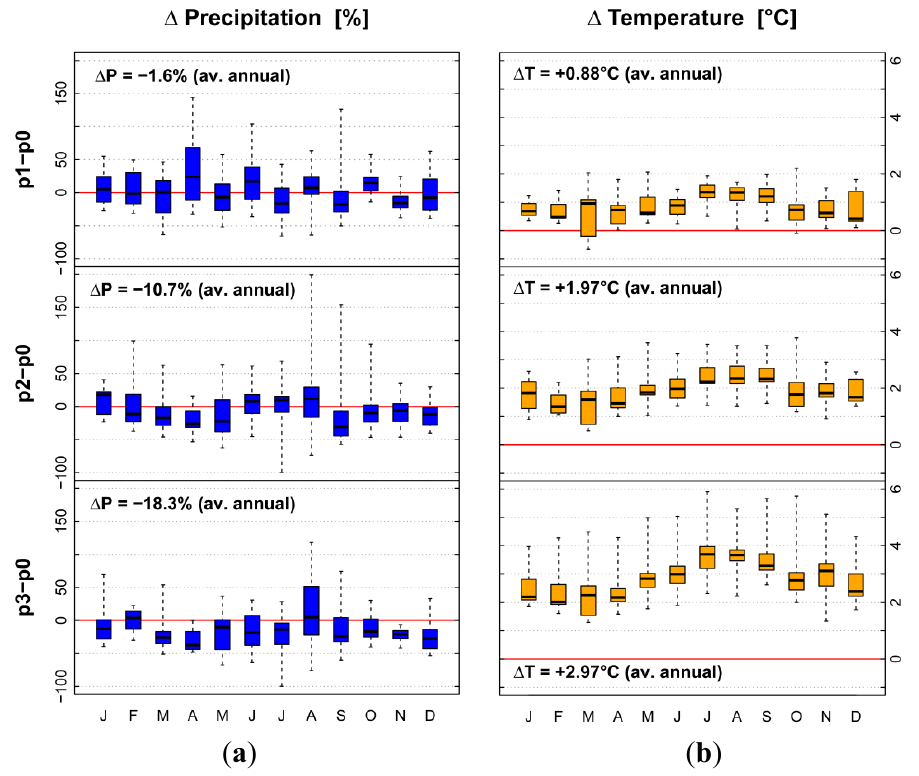
Figure 3. Average monthly climate change signals for the three future scenario periods (p1, p2 and p3) compared to the reference period (p0) for precipitation ( a ) and temperature ( b ) shown as boxplots, where the whiskers represent the min/max values, the boxes the 25th/75th percentiles and the thick lines the median values of changes for 15 climate